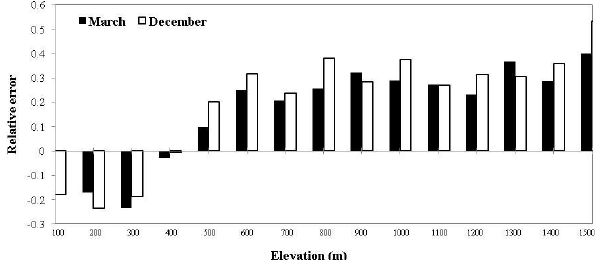
Figure 5 Comparisons between SRTM and ASTER DEM showing the relative error of 591 Fig. 5. Comparisons between SRTM and ASTER DEM show- ing the relative error of the two DEMs March and December from